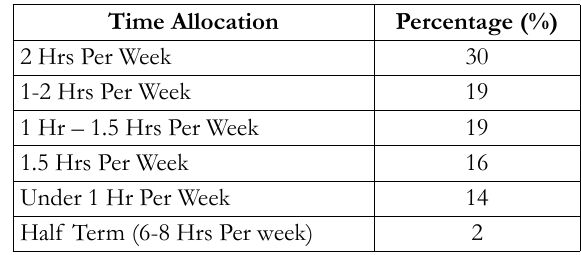
Table 7. Percentage of teacher responses for time allocation. (Questionnaire)